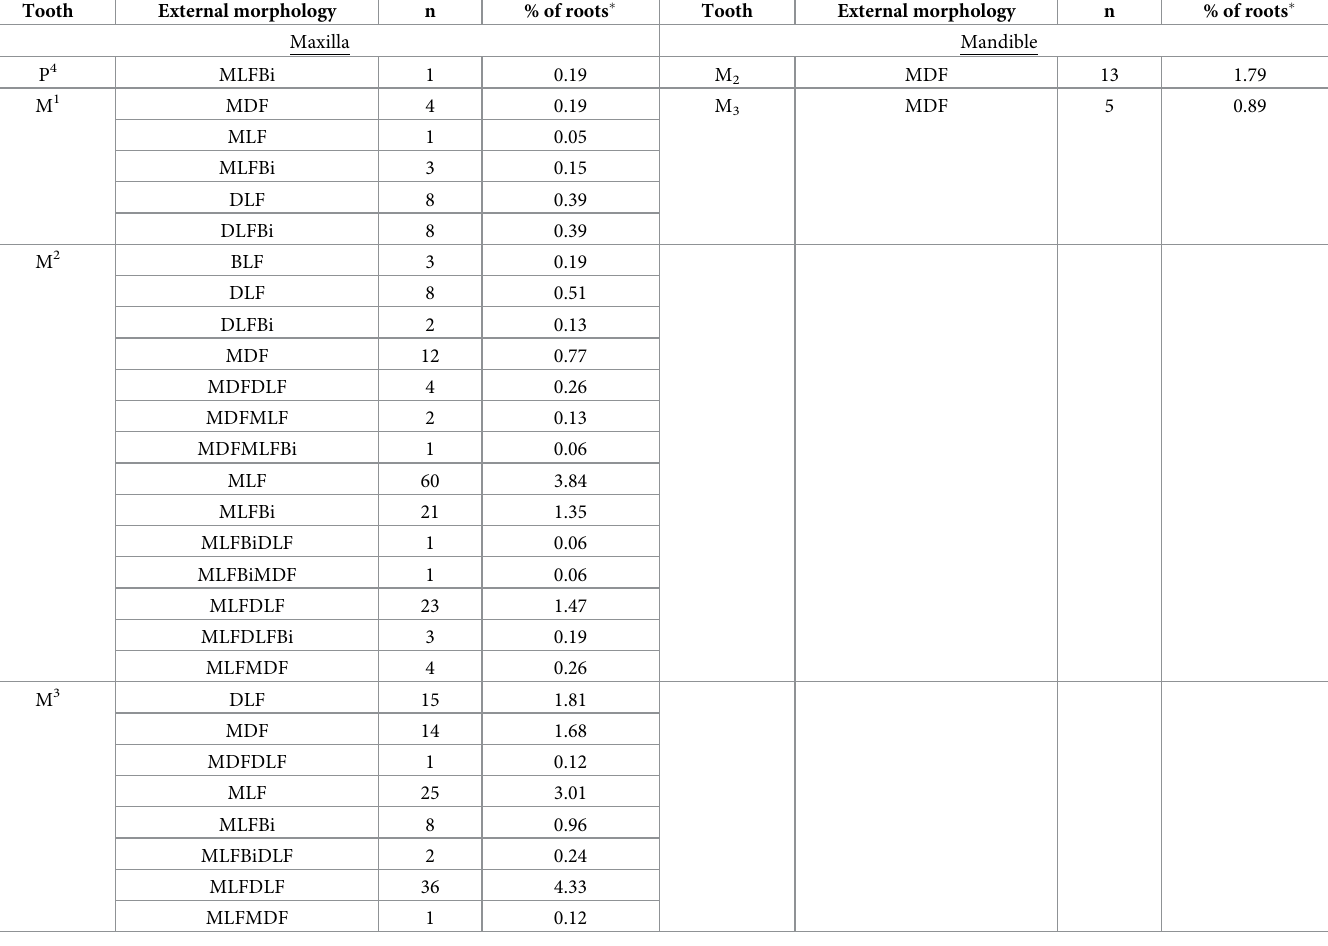
� from Table 3. M = Mesial, B = Buccal, D = Distal, L = Lingual, F = Fused, Bi = bifid apex. Ex: MLF = mesio-lingual fused roots, MLFBi = mesio-lingual fused roots with bifurcation. Congenitally absent teeth not included in statistics for this